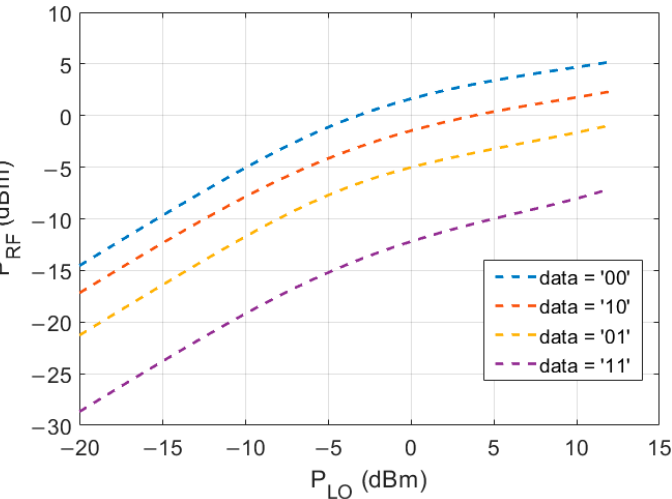
Figure 7. ADS simulation result of the RF output power level depending on the LO input power. The LO frequency is 130 GHz. LO frequency is 130